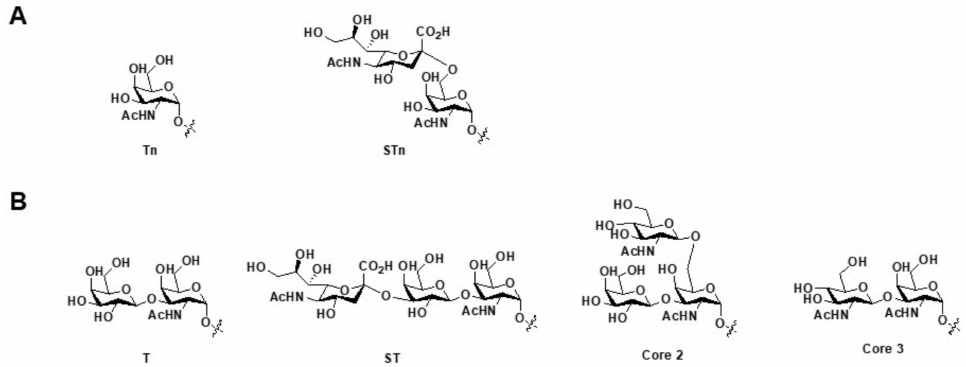
Figure 6. The structures linked to the cross reactivity of glyco-MUC1 antibody 5E5. ( A ) Sugar groups which can be recognized by 5E5; ( B ) Sugar groups which are not recognized by